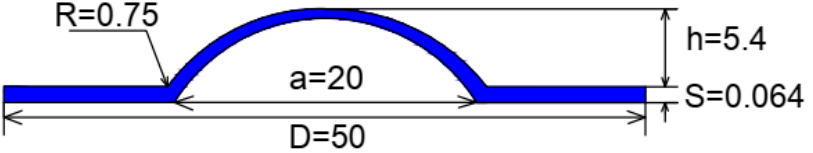
Figure 1. Illustration for the dimensions of the domed rupture disc (unit: mm).